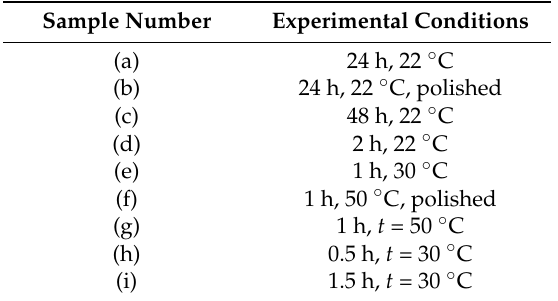
Table 1. Experimental conditions of HA coatings deposition on Mg-alloy substrates by dipping